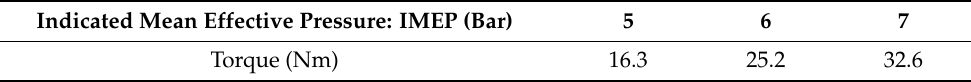
Table 2. Engine operation